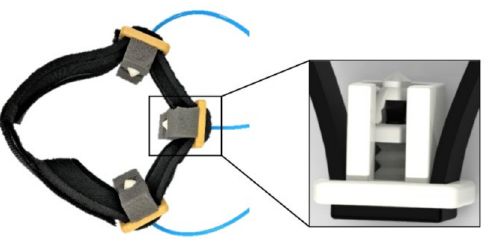
Figure 2. Soft haptic biofeedback system with three units with a padded Velcro